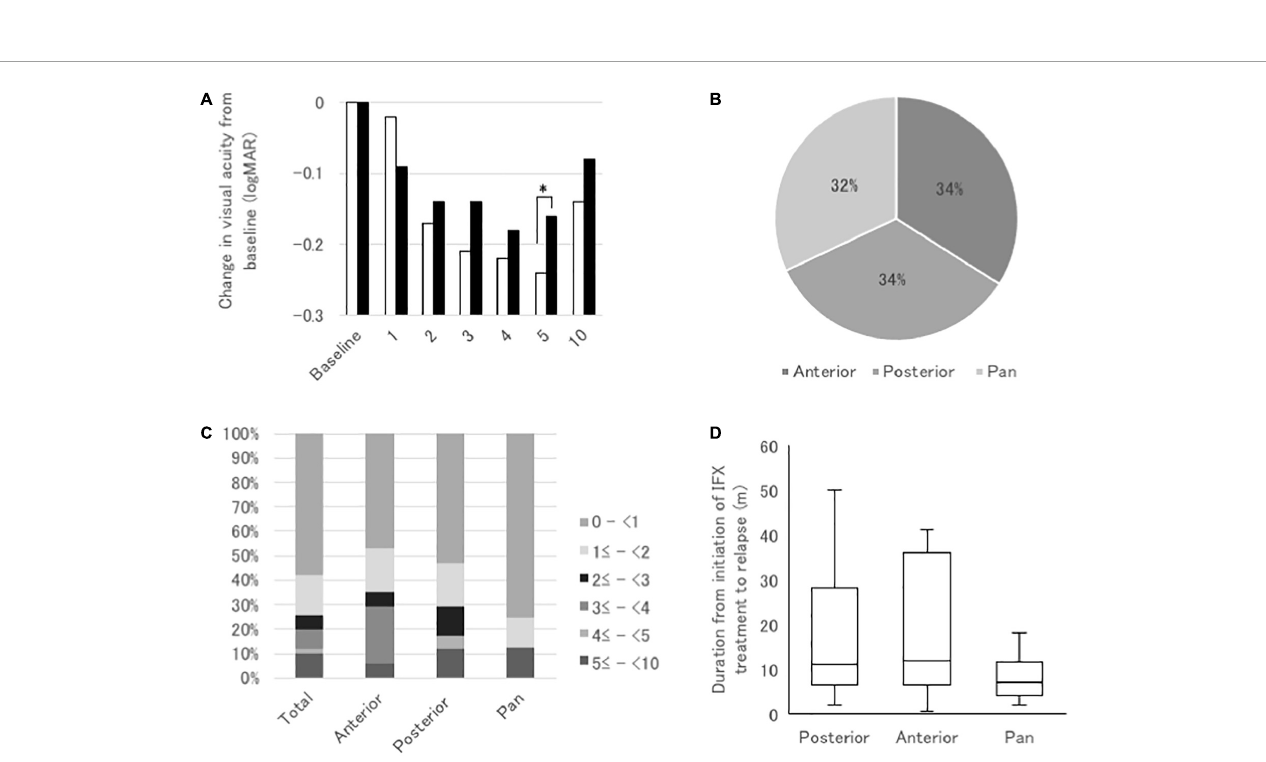
FIGURE4 (A) Comparisons of mean changes in logMAR VA from baseline at 1, 2, 3, 4, 5, and 10 years after initiation of infliximab (IFX) between BD patients with uveitis recurrence after IFX initiation (closed bars) and those without recurrence (open bars). ∗ P < 0.05 by Mann–Whitney U test. (B) Pie graph of proportions of recurrent uveitis classified by the main anatomical site of ocular inflammation; anterior uveitis, posterior uveitis, and panuveitis. (C) Bar graph of proportions of eyes with different durations from IFX initiation to uveitis relapse in three types of recurrent uveitis. (D) Box plot of duration from IFX initiation to uveitis relapse in three types of recurrent uveitis. ∗ P < 0.05 by Steel-Dwass